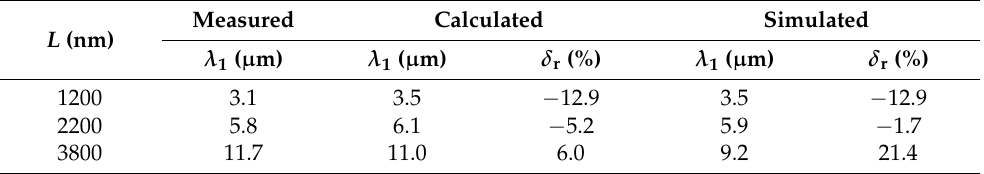
Table 2. Comparison of the results of the examination of the basic dipole